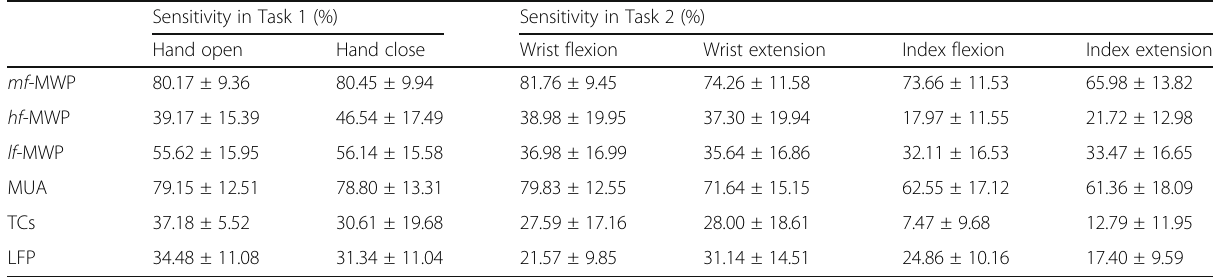
Table 5 Sensitivity of the individual decoders when using different neural features as input Sensitivity in Task 1